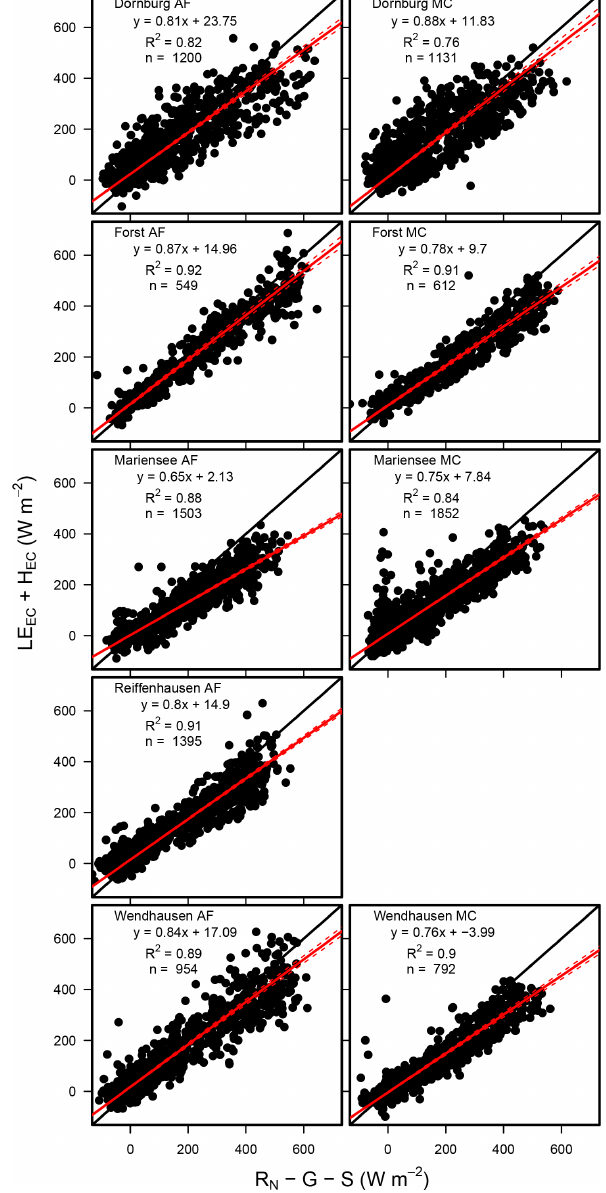
Figure 5. Scatterplot of the sum of the turbulent fluxes (LE EC + H EC ) vs. the sum of the available energy ( R N − G − S ) for all sites. Each plot contains the linear regression equation, the coefficient of determination ( R 2 ), and the number of data points used for the anal- ysis ( n ). Data for Reiffenhausen MC are missing due to the unavail- ability of a